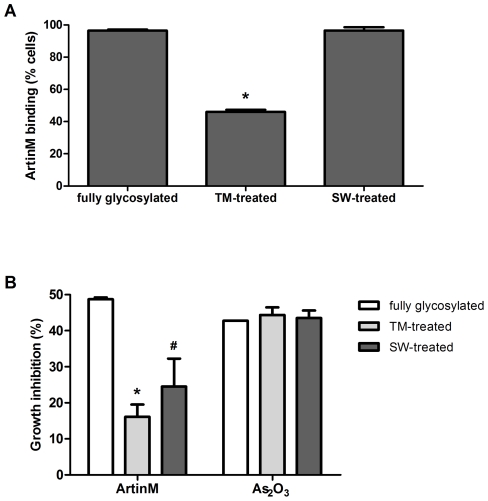
N-Glycan recognition by ArtinM accounts for NB4 growth inhibition.
A) ArtinM binding to NB4 cells pre-treated for 24 h with tunicamycin (TM, 5 µg/mL) or swainsonine (SW, 5 µg/mL) was analyzed by flow cytometry. Fully glycosylated: untreated NB4 cells. B) Growth inhibition induced by ArtinM (10 µg/mL) in fully glycosylated cells, and in TM- or SW-treated cells. Growth rate was measured by MTT assay. Bars represent cell growth inhibition by ArtinM relative to the growth of untreated cells. As2O3 (1 µM) was used as a positive control for cell death. The results shown are representative of 3 independent experiments and are expressed as mean ± SD, * p<0.05 (Tukey's test) and # p<0.05 (Student's t-test).